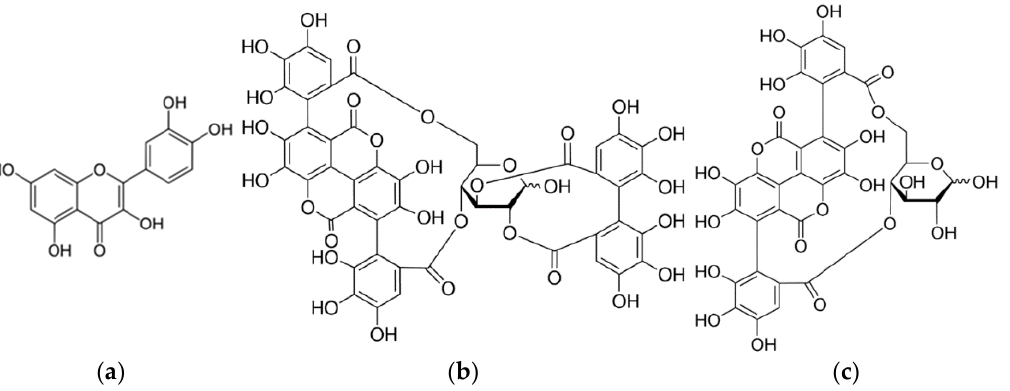
Figure 1. Chemical structures: ( a ) quercetin in onion peel and tannin derivatives in pomegranate peel; ( b ) punicagalin; ( c ) punicalin.